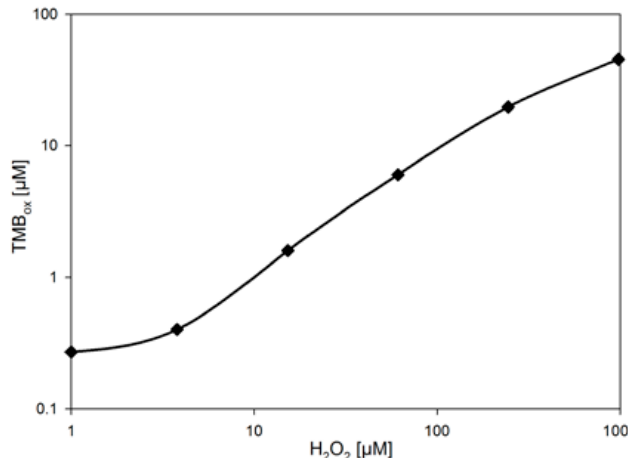
Figure 2. Generated TMBox after 5 min in dependency on the initial H 2 O 2 concentration.